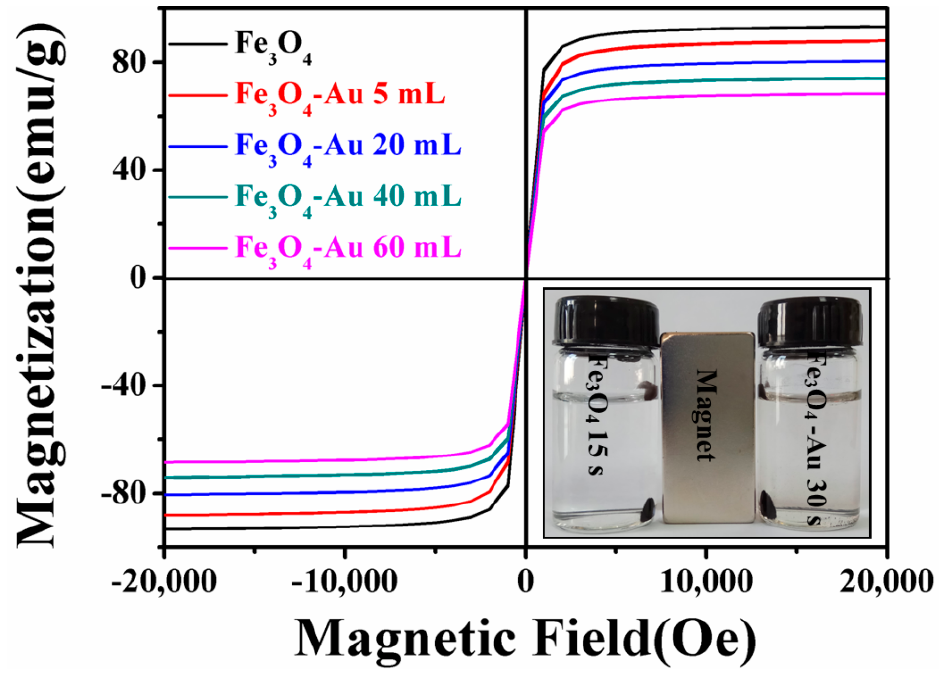
Figure 7. Magnetic hysteresis (M-H) loops of Fe 3 O 4 , Fe 3 O 4 -Au 5 mL, Fe 3 O 4 -Au 20 mL, Fe 3 O 4 -Au 40 mL and Fe 3 O 4 -Au 60 mL. The inset is the photograph of pure Fe 3 O 4 hollow microspheres and Fe 3 O 4 -Au 60 mL magnetic nanocomposites in deionized water after using a magnet.